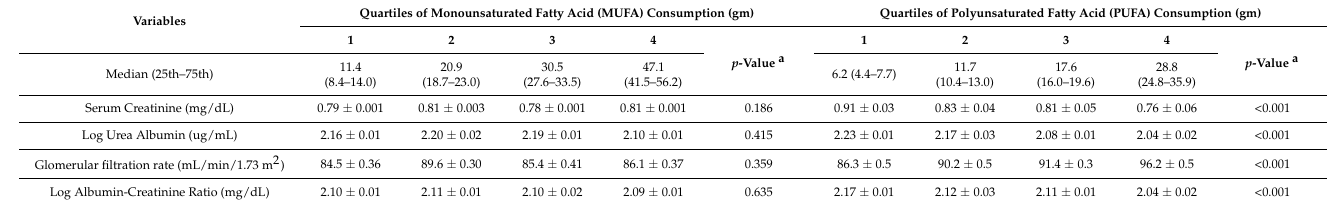
Table 2. Age, sex, race, fasting blood glucose, systolic and diastolic blood pressure, energy in- take, red meat intake, body mass index, diabetes, and hypertension—adjusted mean of markers of kidney function across quartiles of monounsaturated fatty acids and polyunsaturated fatty acids consumption.